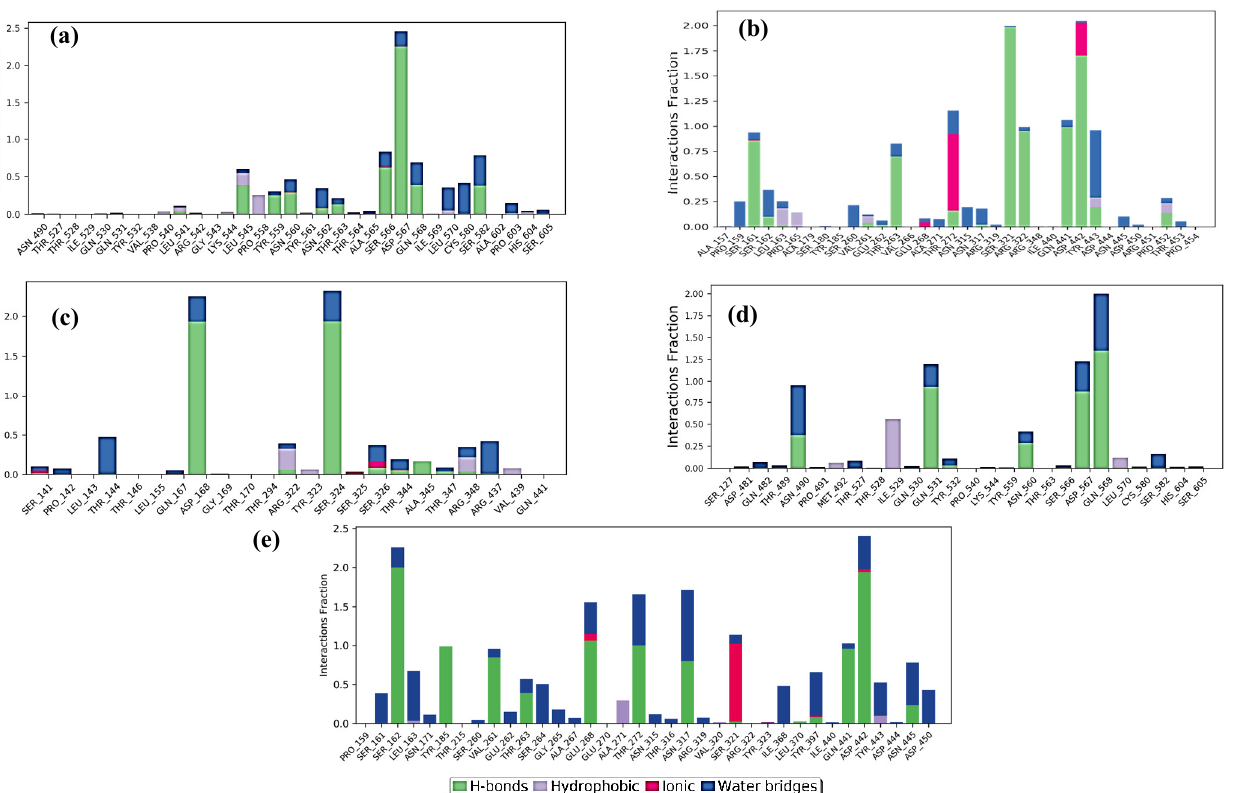
Figure 6. Protein–ligand contact histogram. Protein structures complexed with ( a ) GSTR peptide; ( b ) TDGH peptide; ( c ) LEEV peptide; ( d ) WDDG peptide; ( e ) EGDE peptide. Similarly, the EGDE–capsid protein complex before and after MD simulation